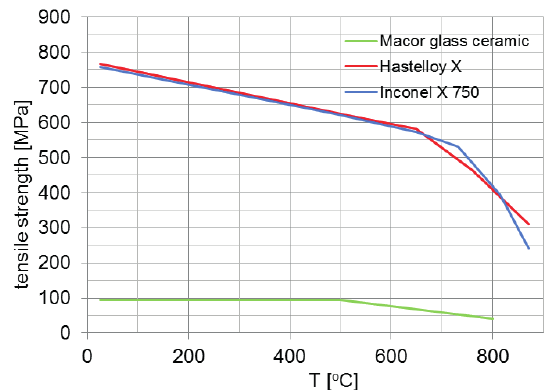
Figure 5: Tensile strength as a function of temperature for selected elements of the mSOFC stack